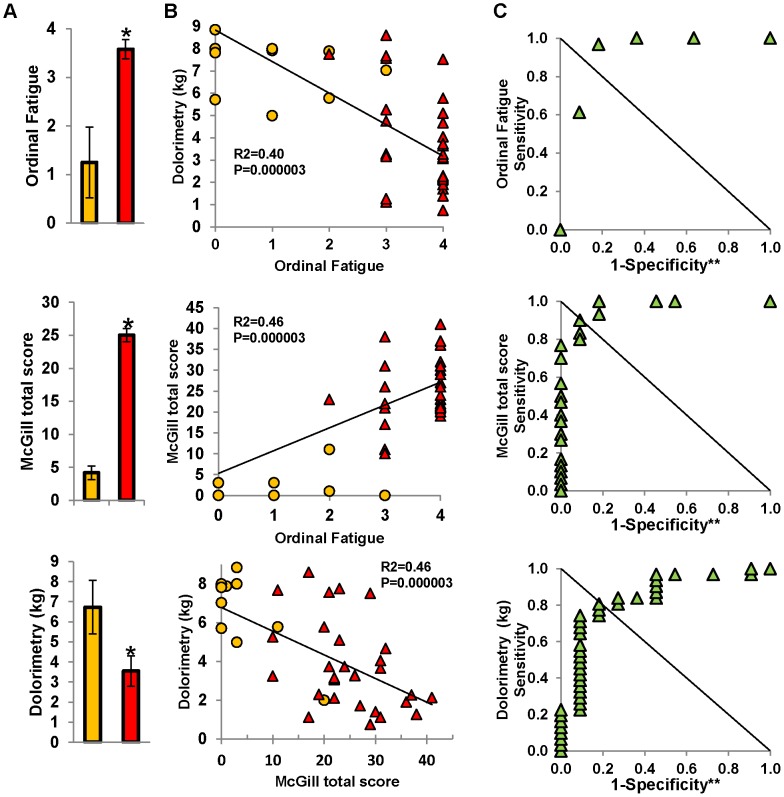
Correlation between McGill total score, mean pain threshold and fatigue.(A) The bar graphs show the magnitudes of the significant differences in ordinal fatigue (*
P = 1×10−9), McGill total score (*
P = 1×10−9), and pain threshold by dolorimetry (*
P = 6×10−4) for control (orange) and CMI (red) groups. (B) Scattergrams from all subjects show the relationships between clinical measures. Dolorimetry pressures negatively correlated with McGill total score and fatigue ratings for control (orange) and GWI (red) subjects. McGill total pain and ordinal fatigue were positively correlated. (C) ROC analysis set the threshold for separation of controls from CMI subjects at 2.5 for ordinal fatigue (specificity = 0.818; sensitivity = 0.968; AUC = 0.915; **P = 0.00005). The threshold for dolorimetry was 5.8 kg (specificity = 0.73; sensitivity = 0.84; AUC = 0.845; **P = 0.0007). McGill total score of 14 separated CMI from controls (specificity = 0.90; sensitivity = 0.91; AUC = 0.973; **P = 4.4×10−6). (*P<0.001, FDR corrected; **P<0.05; Asymptotic significance; error bars depict ±95% confidence intervals).